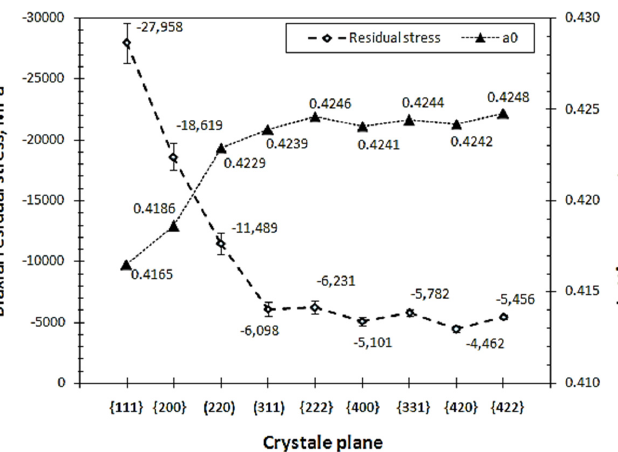
Figure 5. Residual stresses and stress ‐ free lattice parameters of the TiN following the { hkl } mode.